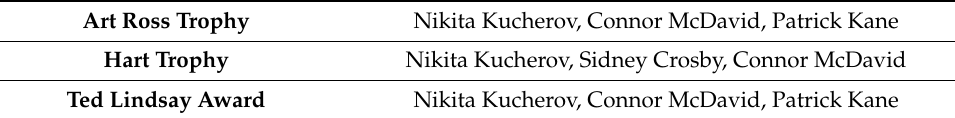
Table 3. Players nominated for selected awards for the 2018/2019